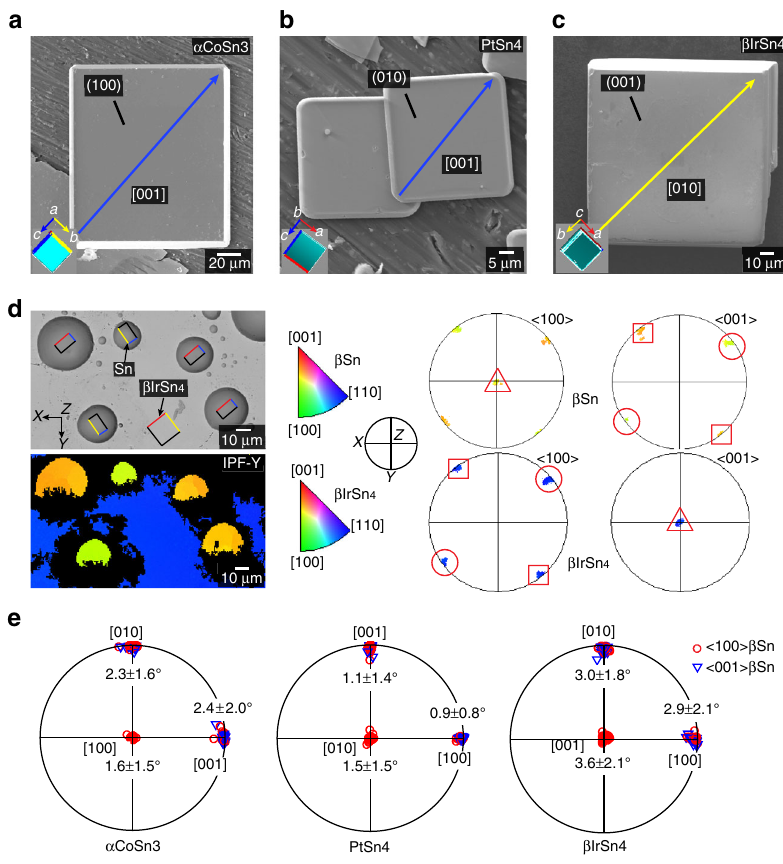
Fig. 3 Nucleation of Sn droplets on the facets of single-crystal IMCs. a – c Typical α CoSn 3 , PtSn 4 , and β IrSn 4 single crystals. The growth habit is shown in the inserts using unit cell orientations measured by EBSD. The largest facets are parallel to the Sn net plane in Fig. 2a in each phase. d A typical example of Sn droplets solidi fi ed on the (001) facet of β IrSn 4 and the corresponding EBSD IPF-Y map and pole fi gures. Each β Sn droplet is a single crystal. The superimposed unit cells have a -, b -, and c-axis labeled using the same color as a – c . The pairs of triangles, circles, and squares in the pole fi gures are near- parallel directions in the β Sn droplets and the β IrSn 4 crystal. e Summarized pole fi gures of β Sn orientations with respect to the largest facets of α CoSn 3 , PtSn 4 , and β IrSn 4 based on 41, 105, and 36 measurements, respectively. All measured orientations have been rotated towards one equivalent orientation by exploiting symmetry. The angular deviation of each pair of near-parallel planes is given as the mean value and standard deviation